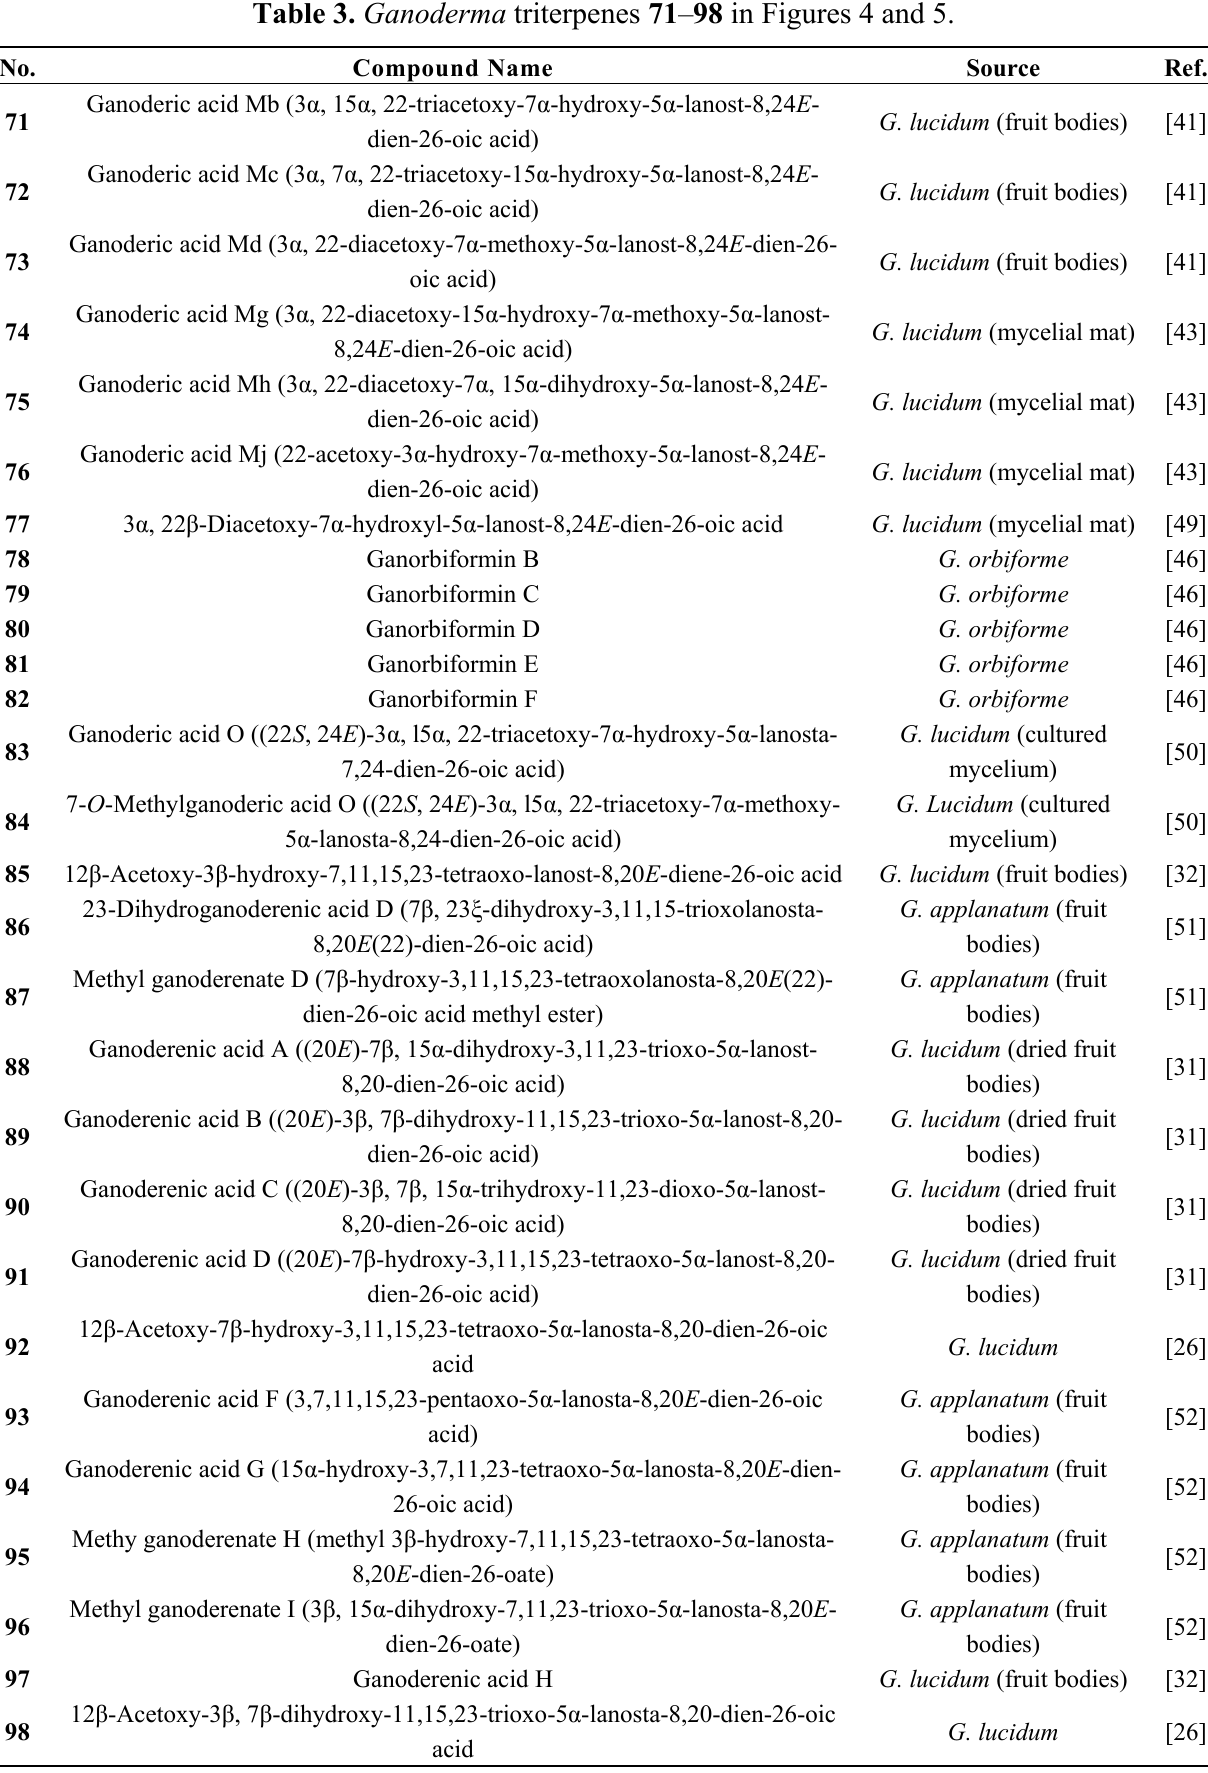
Table 3. Ganoderma triterpenes 71 – 98 in Figures 4 and